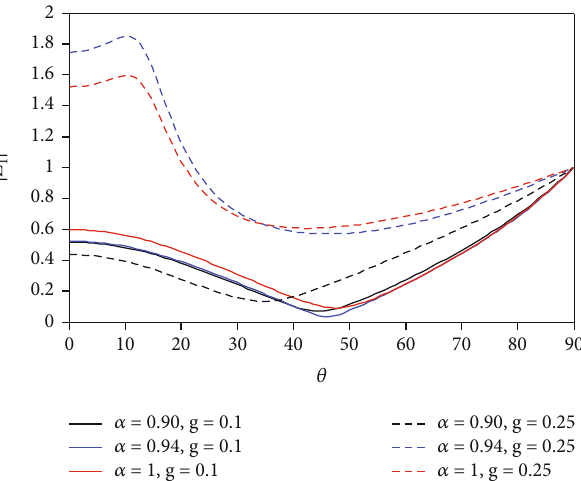
j concerning the 1